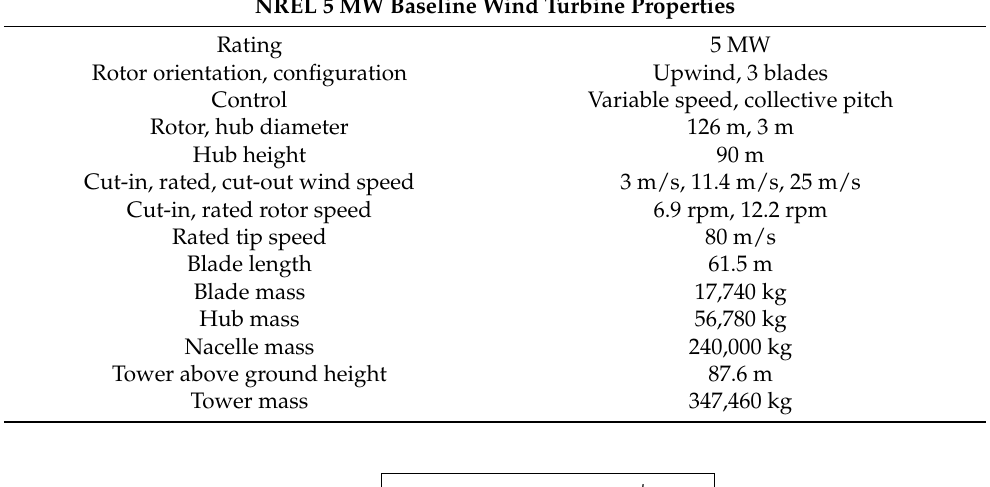
Table 1. Properties of the 5 MW NREL wind turbine [33].